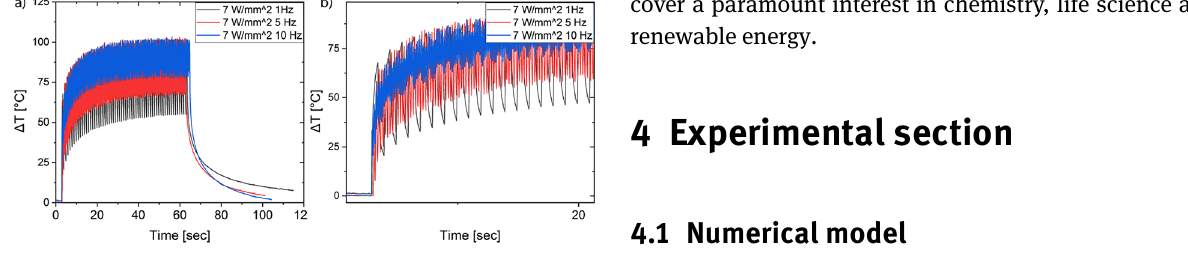
Figure 6: (a) Comparison of experimental macroscopic temperature acquired using an intensity of 7 W ∕ mm 2 and laser chopper frequency of 1, 5, and 10 Hz for gold nano flower covered with 4 μ m thick PVP + R6G layer (b) zoom of the